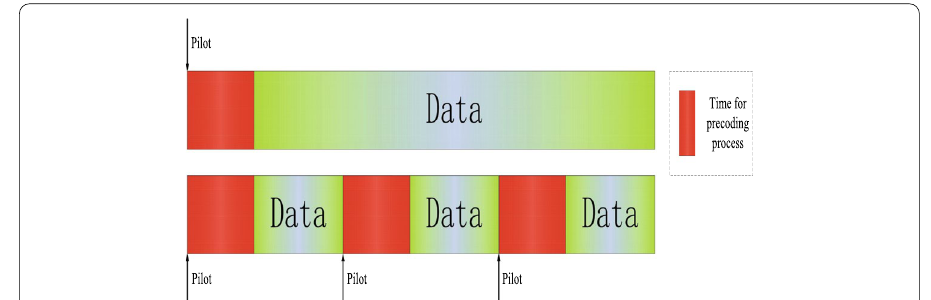
Fig. 5 High cost brought by frequently updating precoder/combiner in time-varying channel. Legend: time for pilot transmitting, channel estimation, precoding calculation and feedback